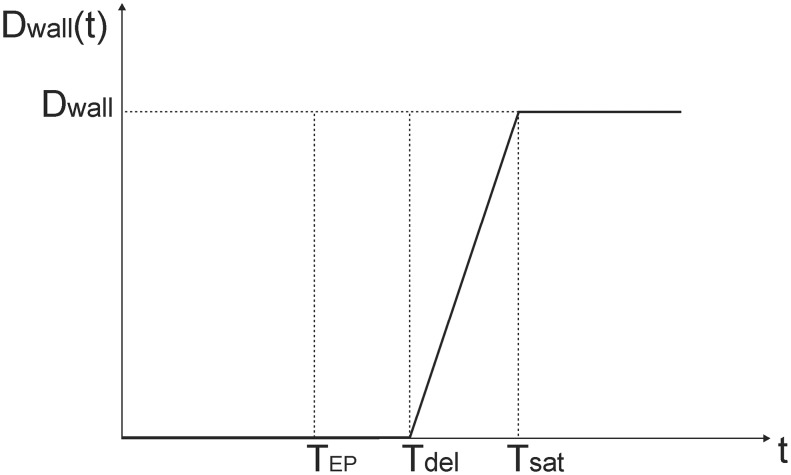
The time-dependent function of apparent diffusion coefficient D
wall(t) of electroporated microvessel wall.
T
EP is the start of electroporation. The delay time T
del and the saturation time T
sat together define the slope of the linearly increasing part of D
wall(t) and the final (saturation) value of D
wall(t): D
wall for t ≥ T
sat.